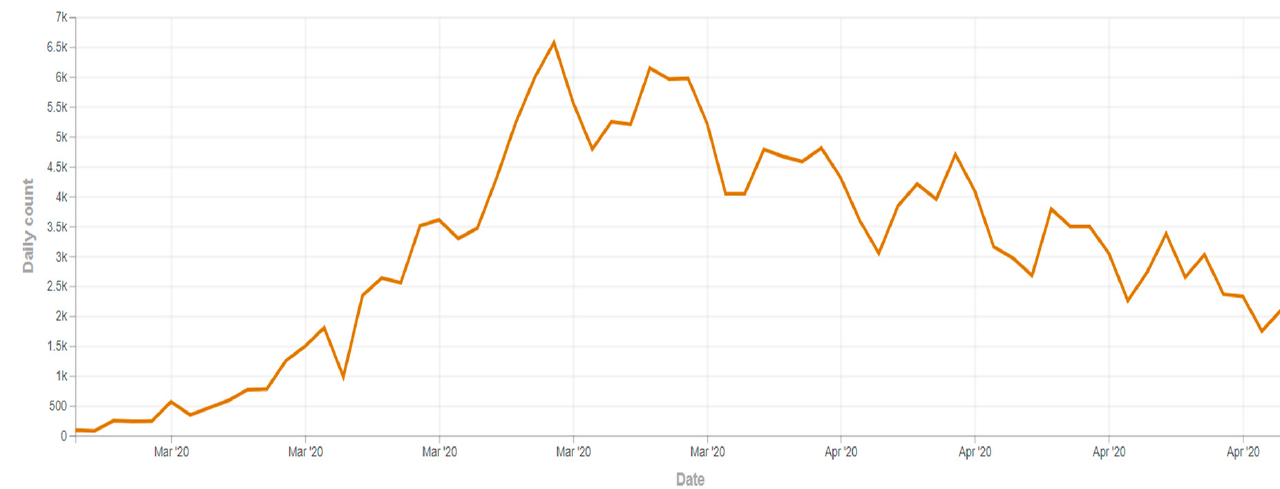
Figure 1. Trend of reported infections of COVID-19 in Italy and data collection of the study (adapted from